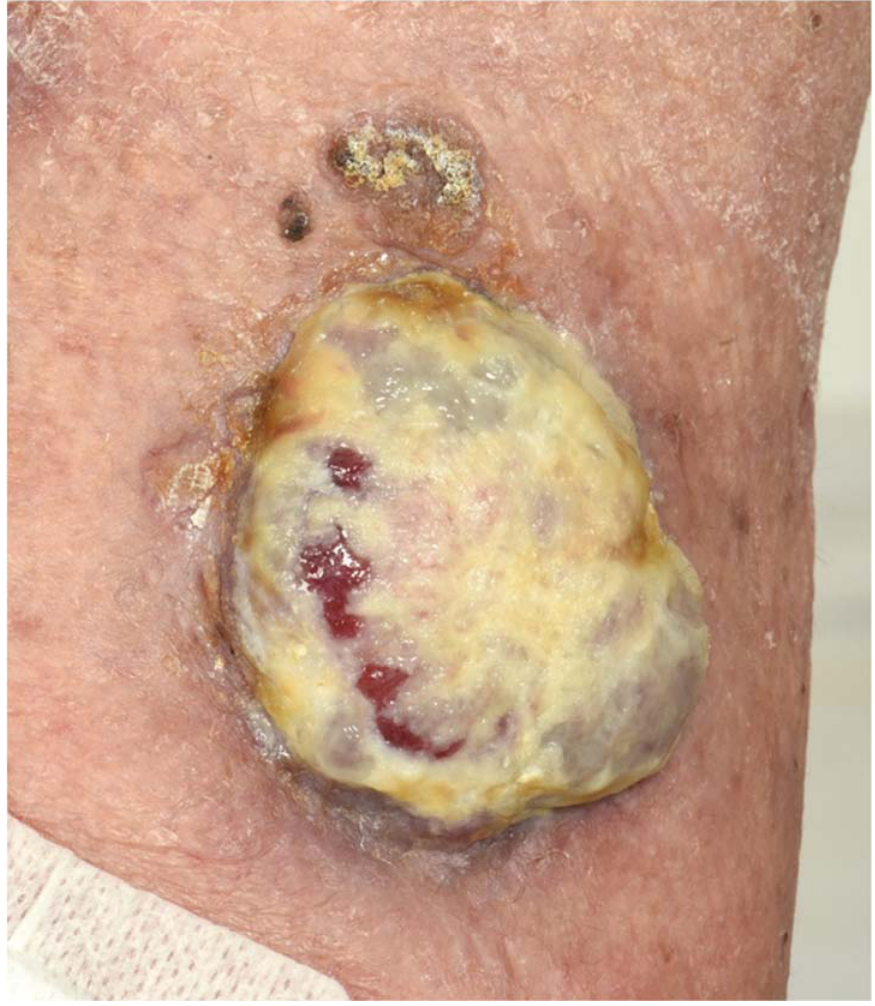
Figure 3. MCC in the Right Anteromedial Thigh of a Kidney Transplant Recipient.